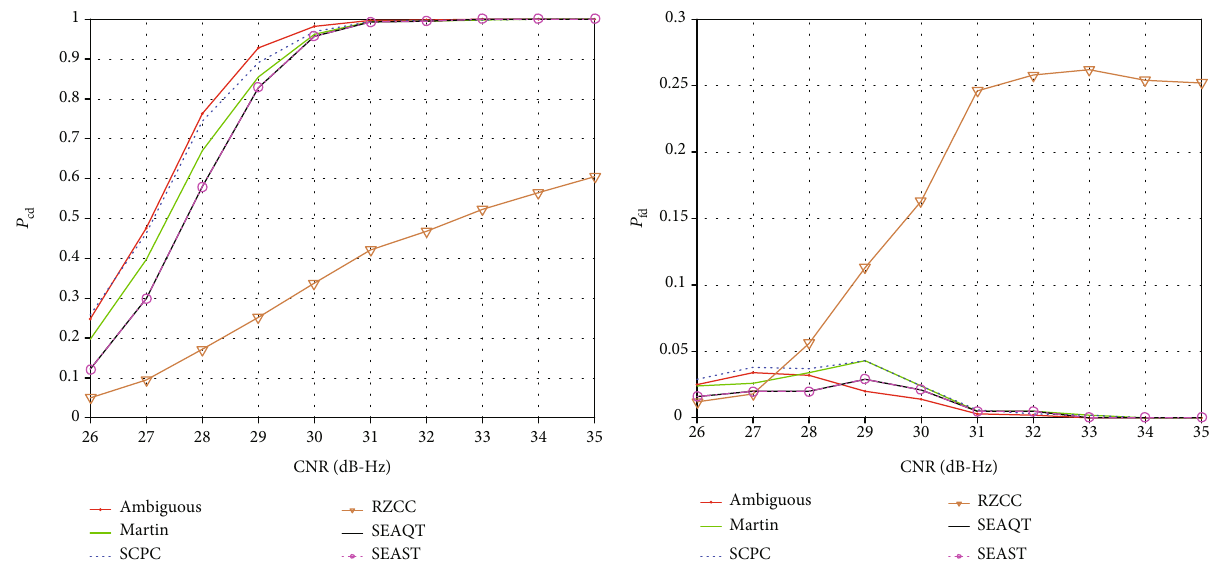
Figure 16: Correct detection probability and false detection probability for sin-BOC (1,